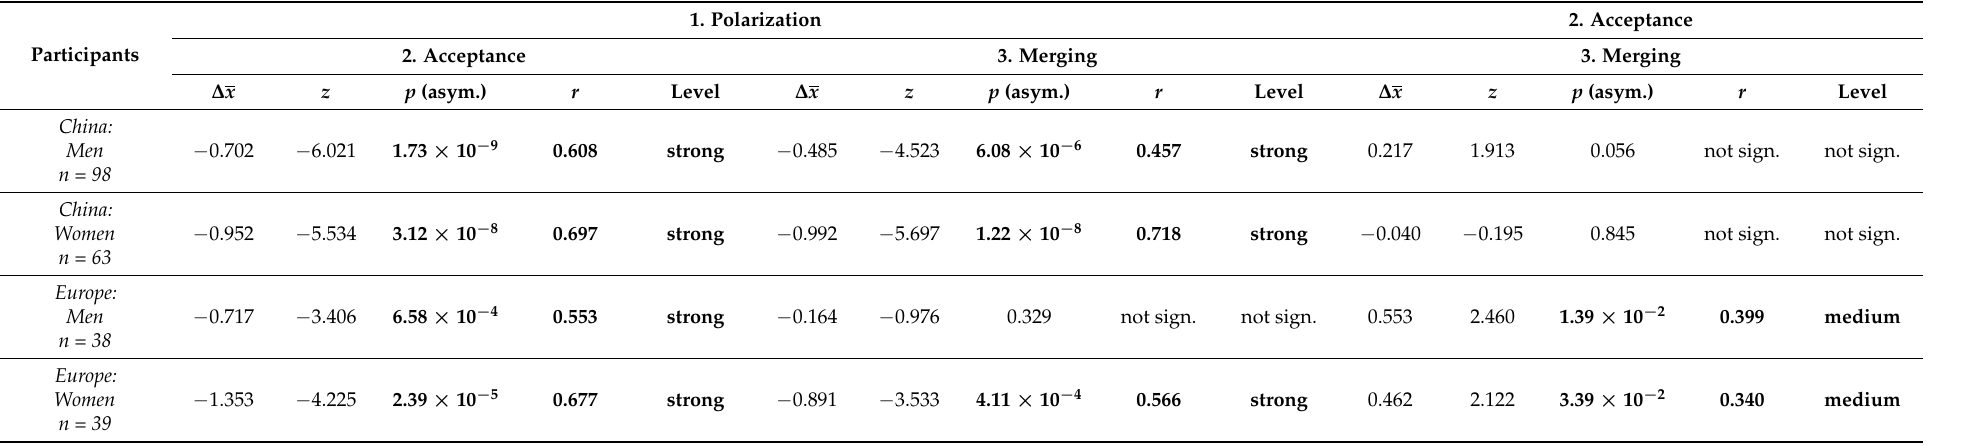
Table 8. Statistical evaluation of the three identified groups, differences of the mean values ∆ x , z-score, probability value p, effect power r and quantification of it.